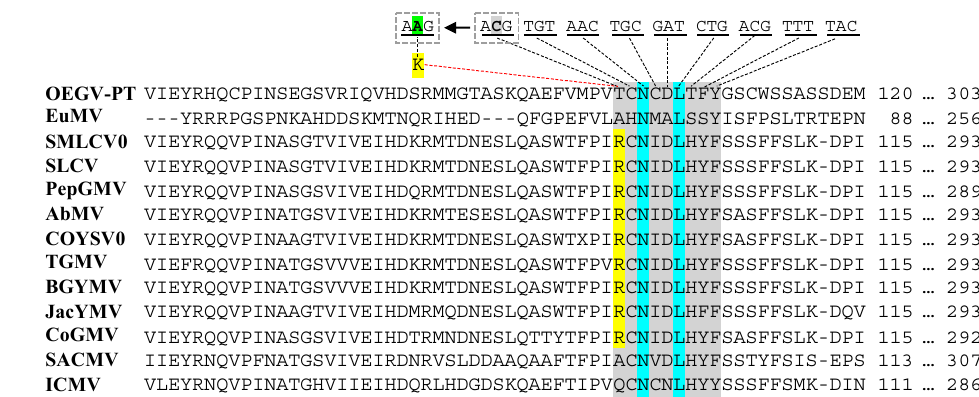
Figure 4. Alignment of OEGV-PT DNA-B MP aa sequences with begomoviruses showing (in gray) the putative tyrosine phosphorylation site [RK]-x(2,3)-[DE]-x(2,3)-Y in the NW Begomovirus and the homologous OW and OEGV-PT region. On top, codons of OEGV-PT sequence are shown. In green is shown how a single nt substitution (C by A) in the first codon of the site would be enough to change the functionality of tyrosine phosphorylation (T by K) in OEGV-PT. Blue shaded aa represent conserved aa among begomoviruses.